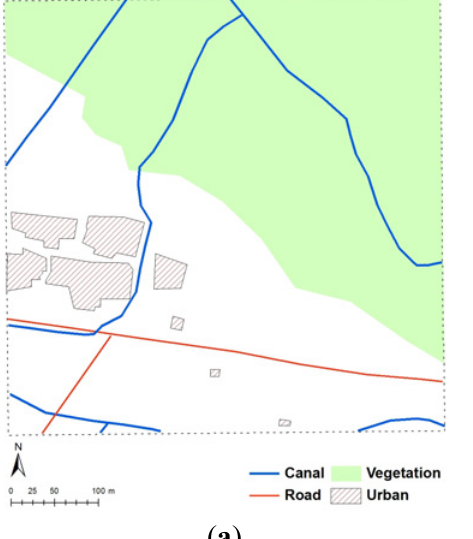
Figure 9. Domlur land cover ( a ) 1885; ( b ) 1935; ( c ) 1973; ( d )